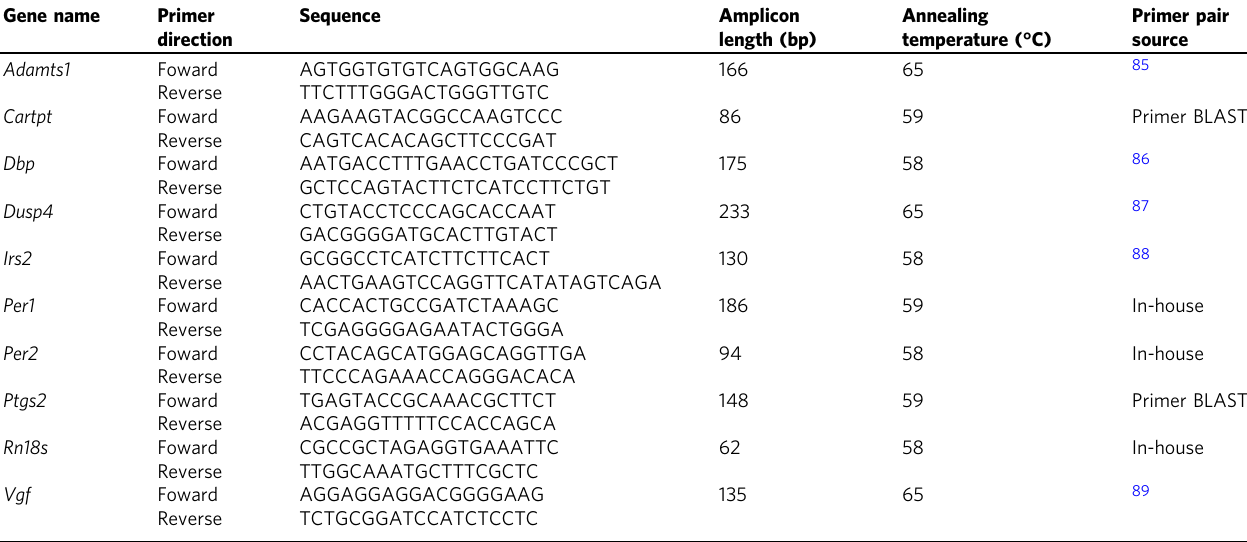
Table 1 Primers used for qPCR of genes to validate microarray